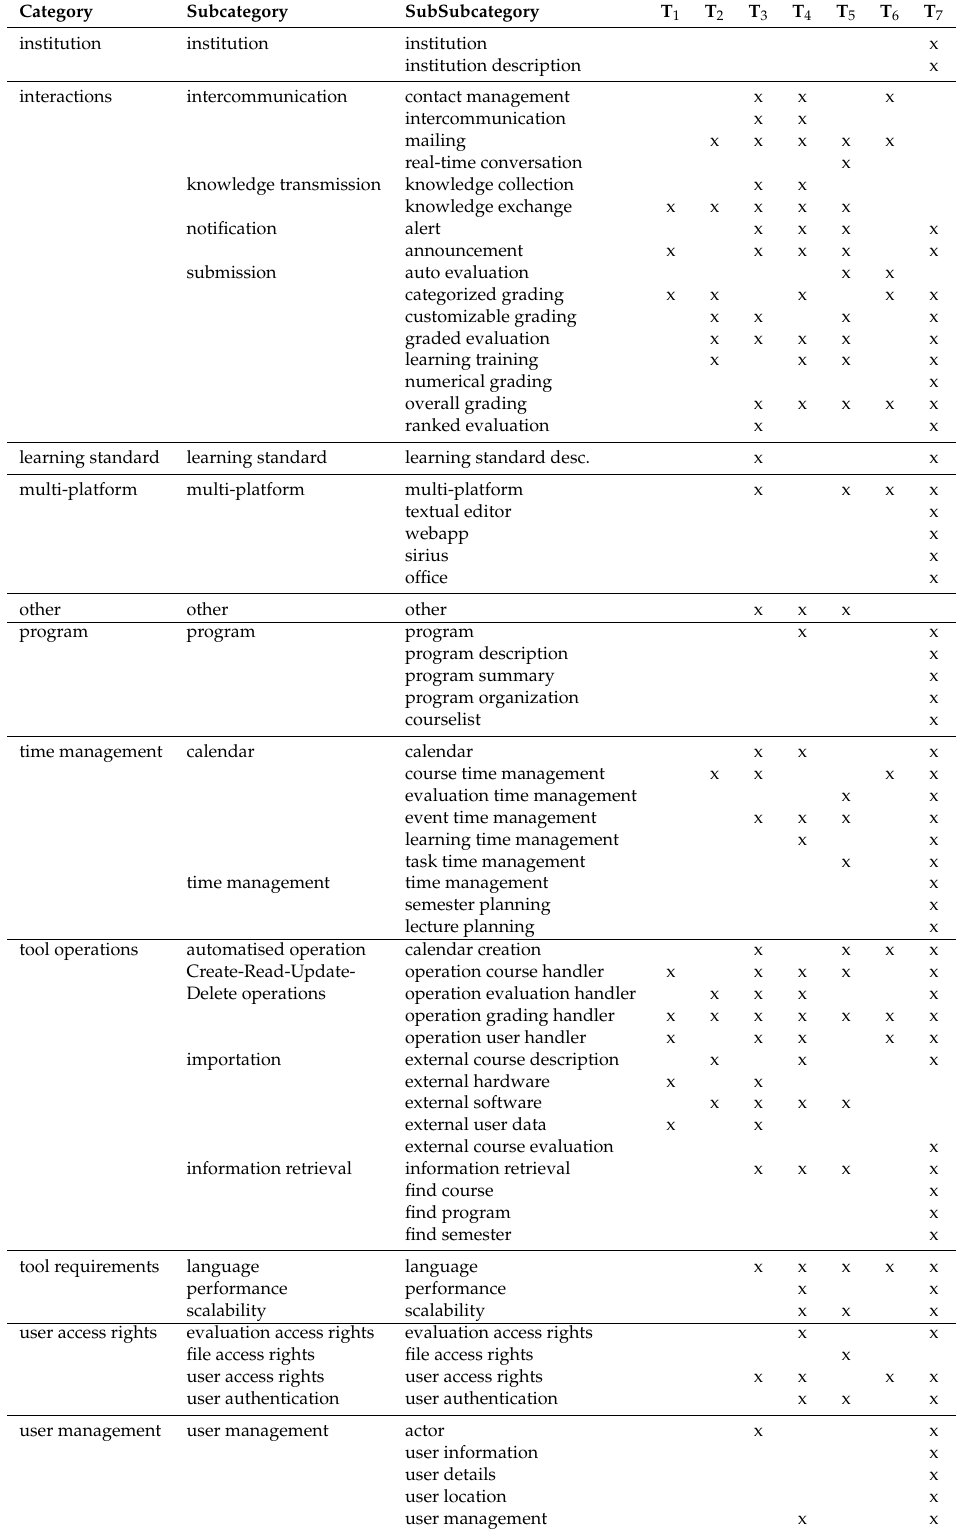
Legend of Table A3: T 1 : Canvas; T 2 : D2L; T 3 : Fedena; T 4 : Moodle; T 5 : Sakai Project; T 6 : Schooltool; T 7 :